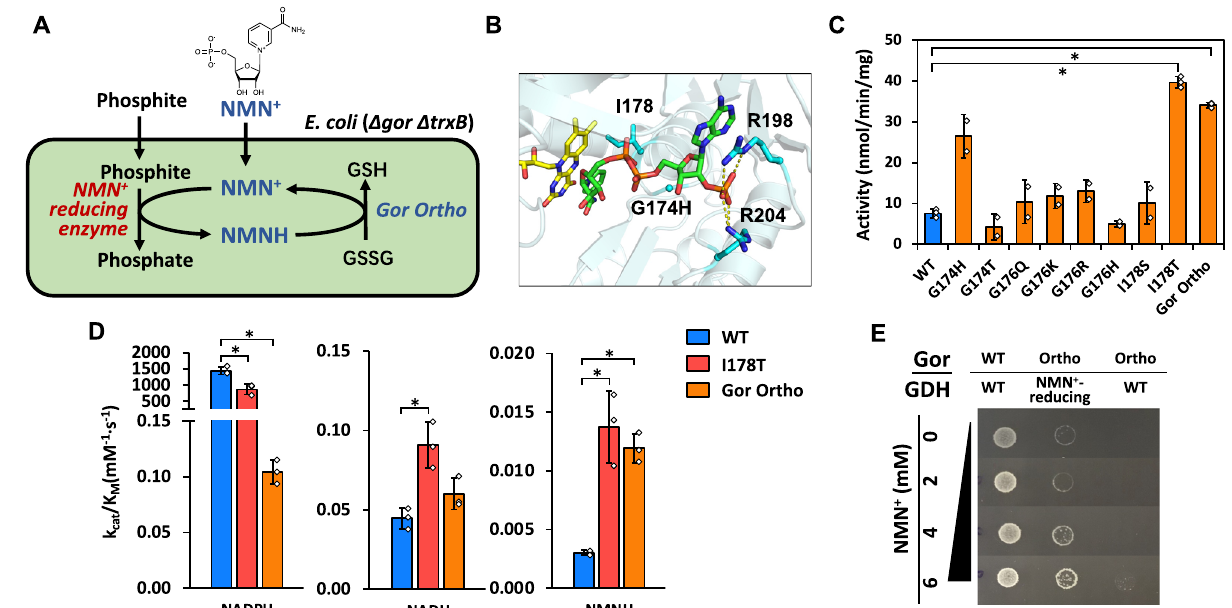
Fig. 1 | Development and validation of the Gor Ortho-mediated growth selec- tion platform. A Schematic of NMN(H) redox system coupling NMN + reducing enzymeandlife-essentialglutathionereductaseinanengineered E.coli strain.Redox imbalance through low supply of NMNH results in insuf fi cient GSH production and protein misfolding. B Structure of the coenzyme binding pocket in Gor from E. coli (PDB: 1GET). Residues interacting with the cofactors are shown as cyan sticks, the native cofactor NADPH is colored green, and the FAD is colored yellow. C In vitro NMNH-dependent activity of eight single-mutation variants in the fi rst round of rational design. For WT, I178T, and Gor Ortho, n =3 biologically independent repli- cates. For all other samples, n =2 biologically independent replicates. For statistics,